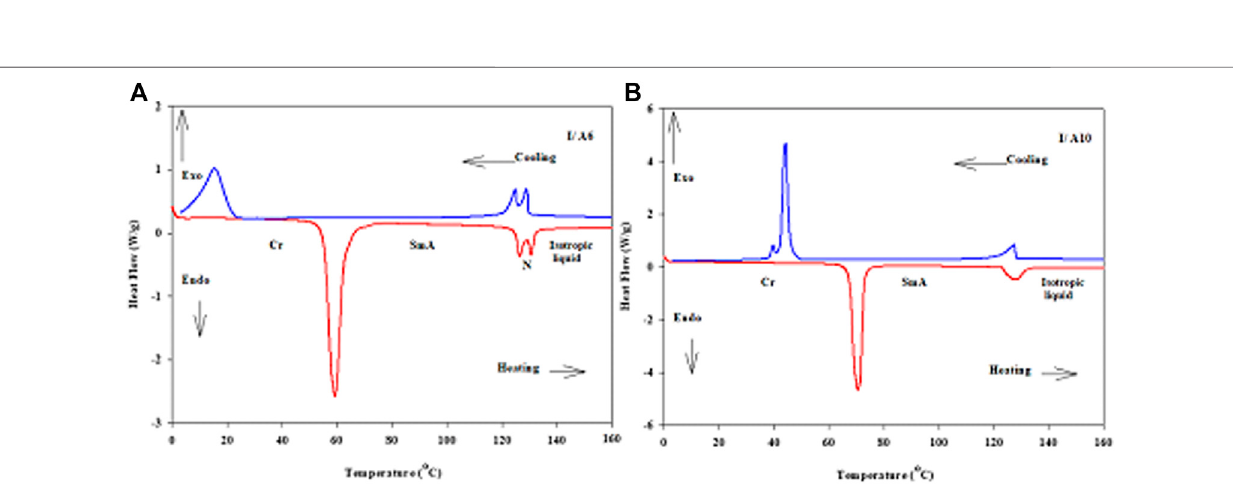
( Δ T (cid:2) Tmeasured – Tlinear) is correlated with the mixture composition in Figure 6B . The 1:1 M supramolecular complex